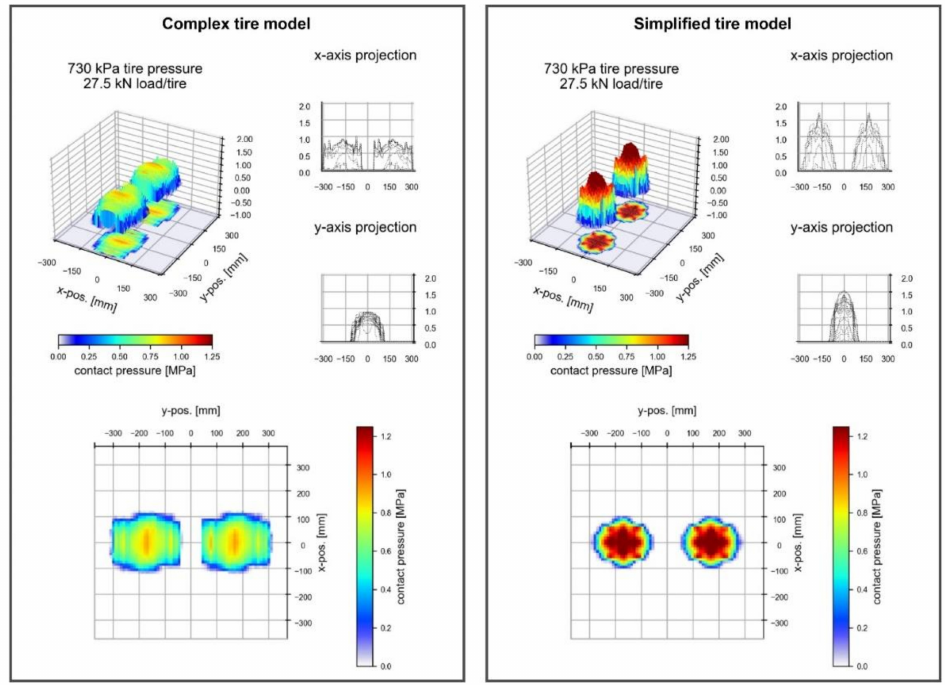
Figure 10. Parts of interaction simulation results: the contact area and contact stress distribution of the complex FEM tyre model ( left panel ) and of the simplified FEM tyre model ( right panel